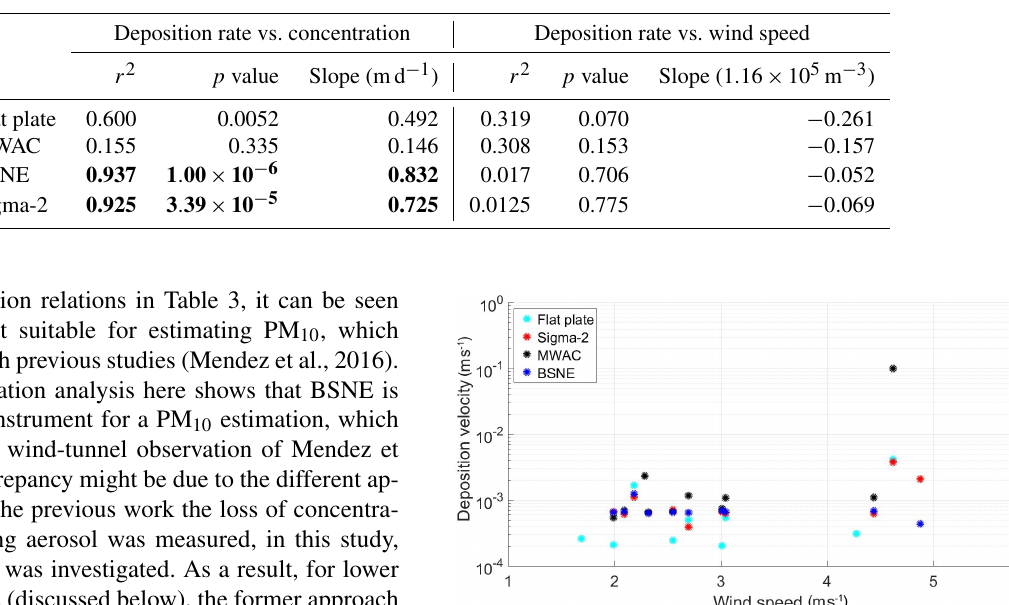
Table 3. Summary of the regression analysis for the correlations between the dust deposition rate and the atmospheric concentrations (PM 10 size range; measured by the OPC), and for the correlations between the dust deposition rates and the wind speeds. Significant relationships are shown in bold.